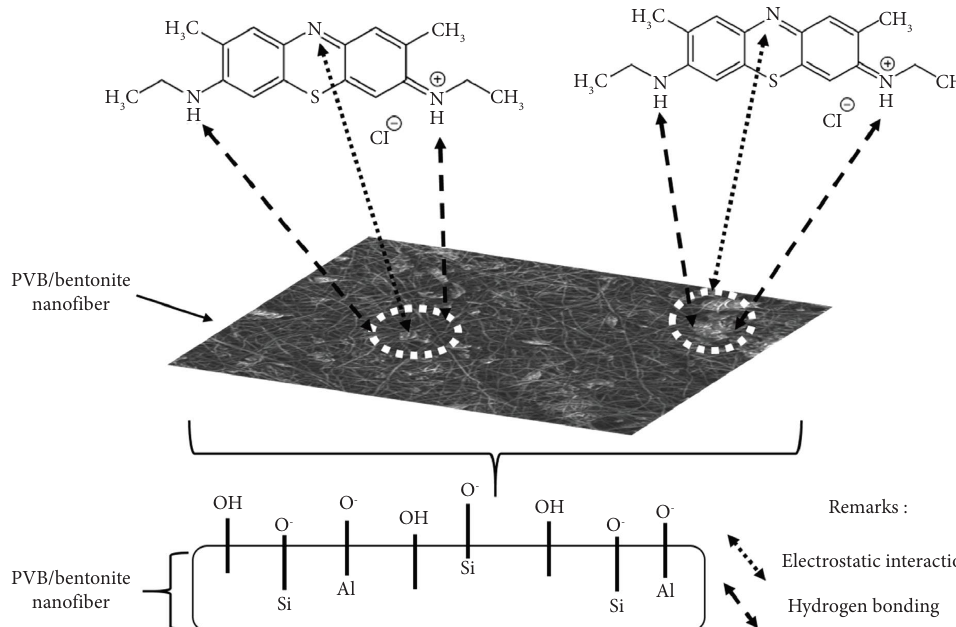
Figure 15: Adsorption mechanism of methylene blue dye on PVB/bentonite